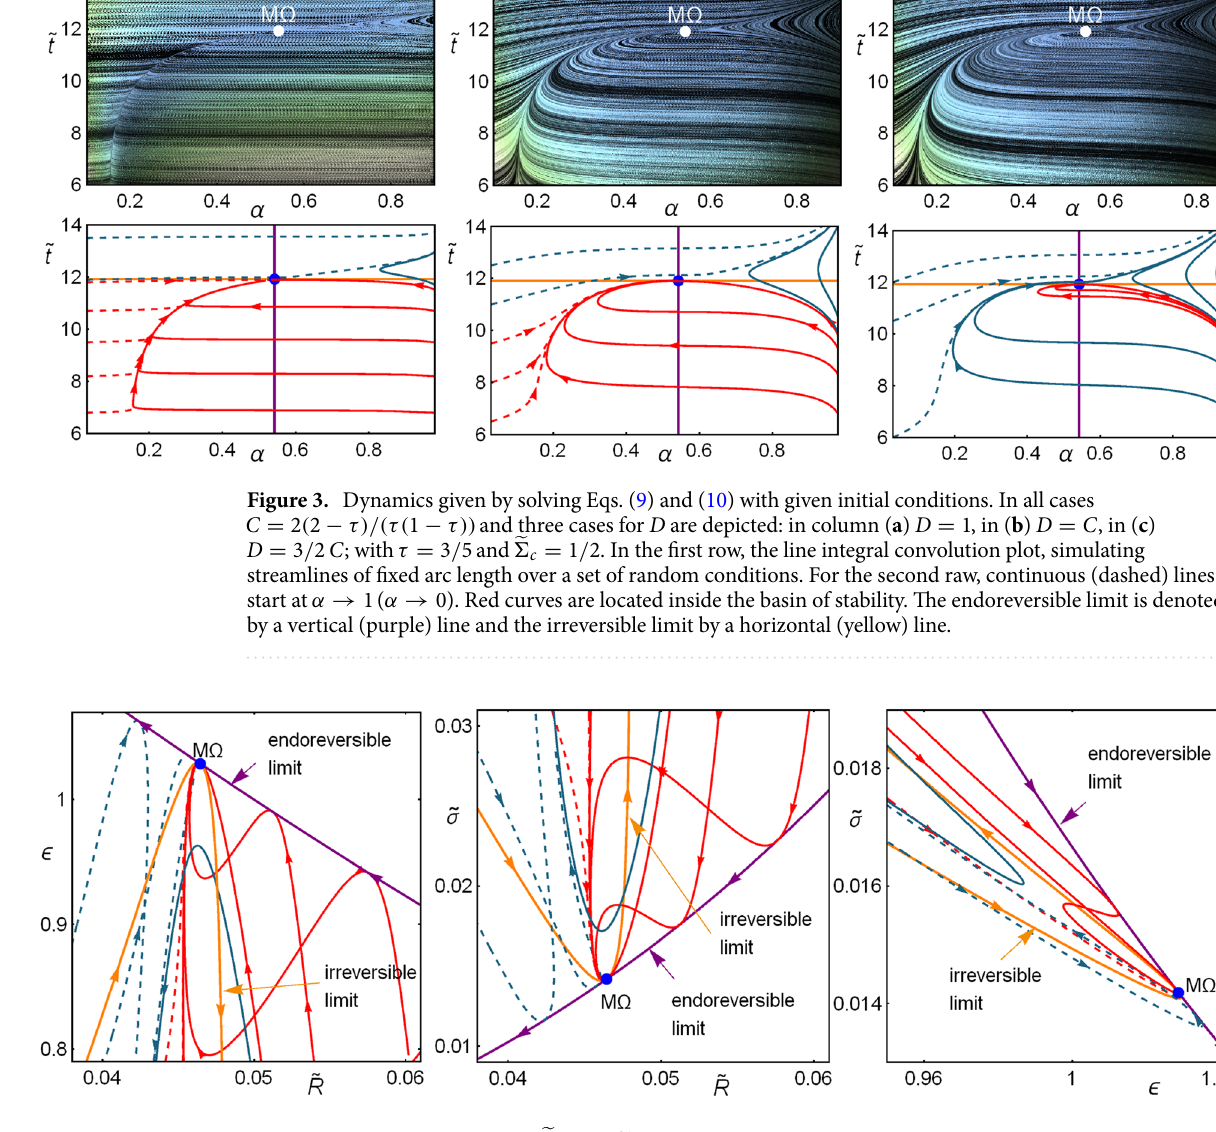
Figure 4. Dynamic evolution of